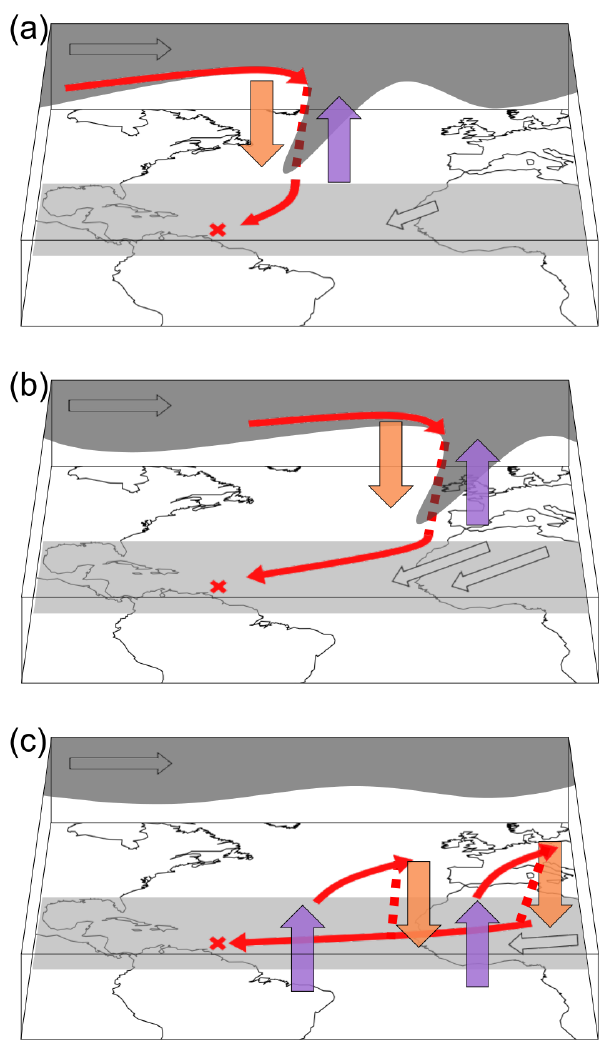
Figure 3. Three-dimensional schematic of the three flow regimes for air parcels arriving in the sub-cloud layer ( p ≥ 940hPa) in Bar- bados. The extratropical dry intrusion regime is shown in (a) , the extratropical trade wind regime in (b) and the tropical regime in (c) . The upper-level westerly flow (e.g. on the 310K isentrope) is indi- cated with the dark-grey surface and the low-level trade wind flow (900–1000hPa) with the light-grey surface. Strong descending mo- tion is shown by orange arrows; strong ascending motion is shown by violet arrows; the red line indicates the air parcels’ typical tra- jectory in each regime, with dashed red representing rapid descent.